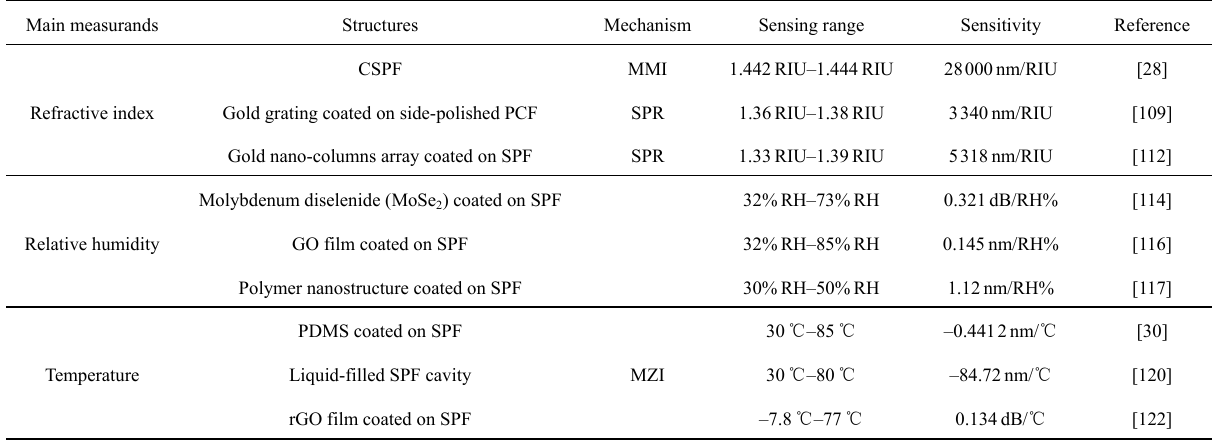
Table 2 Performance of three types of sensors based on the SPF